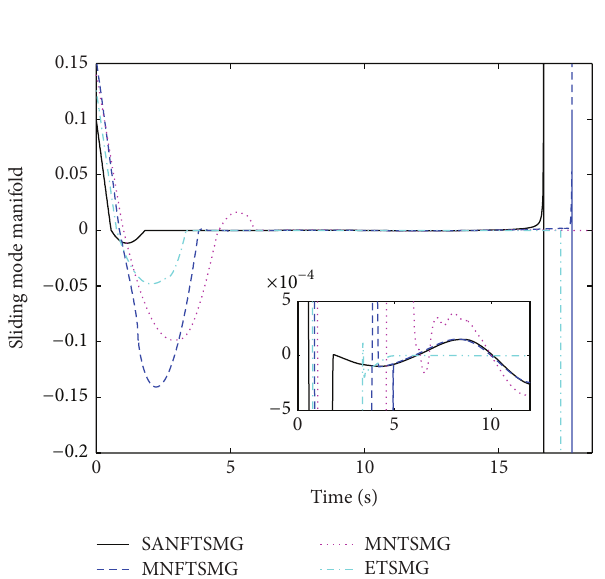
Figure 21: Sliding mode manifold (Case 1).